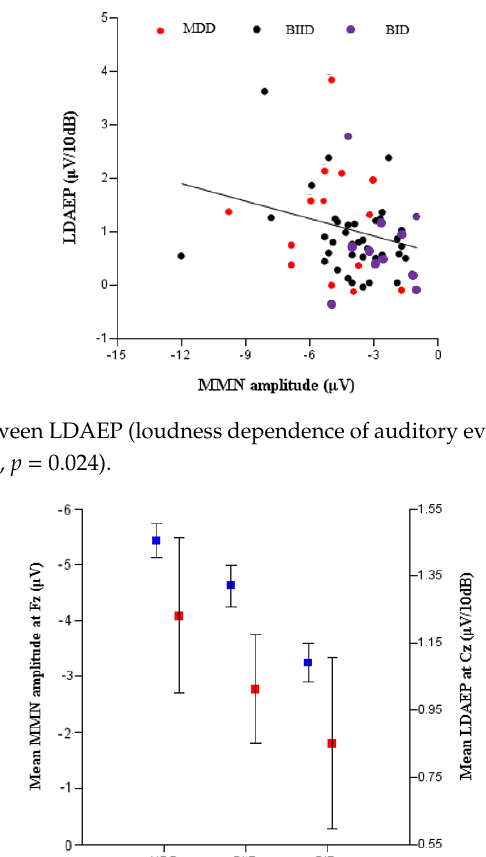
Figure 1. Correlation between K-MDQ (Korean version of the Mood Disorder Questionnaire) and the MMN (mismatch negativity) amplitude (F4) ( r = −0.37, p = 0.014).